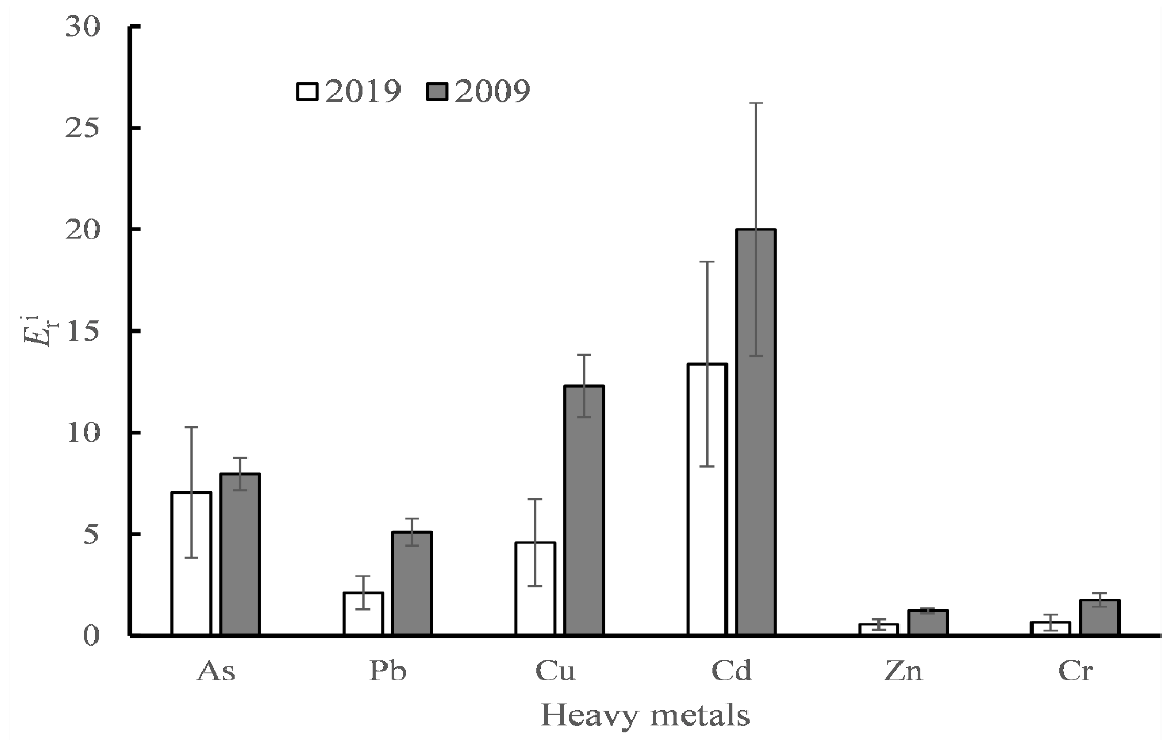
Figure 6. E i r value of heavy metals calculated from data in 2019 and that of 2009 from literature [32]. Figure 6. 𝐸 𝑟𝑖 value of heavy metals calculated from data in 2019 and that of 2009 from